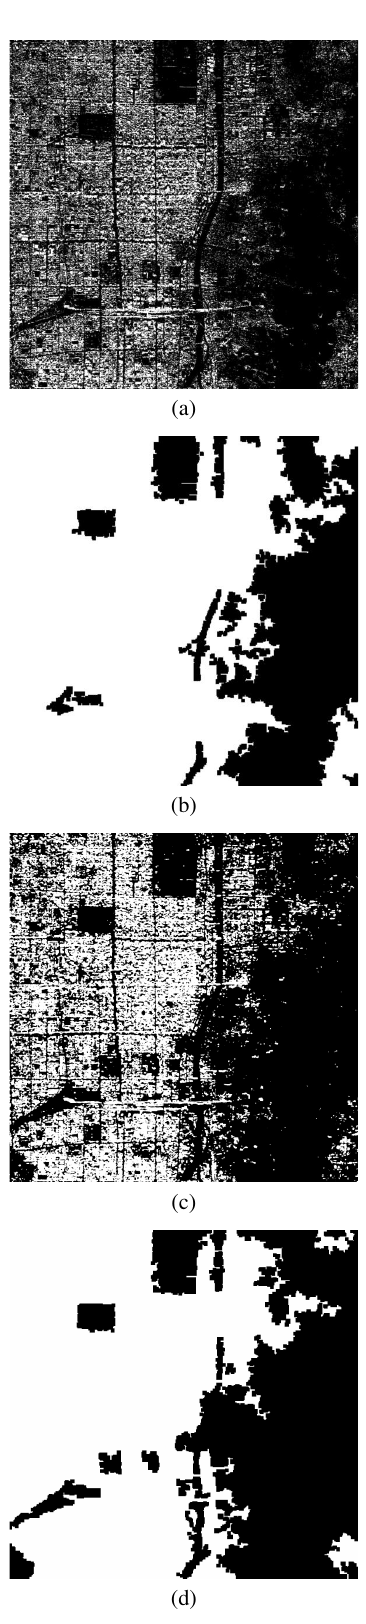
Figure 9. Comparison of classification results in study area 2. (a)(b) Results by using the proposed method before and after post-processing, respectively, and (c)(d) the result by using the method of Esch et al.(2013) before and after post-processing, re-